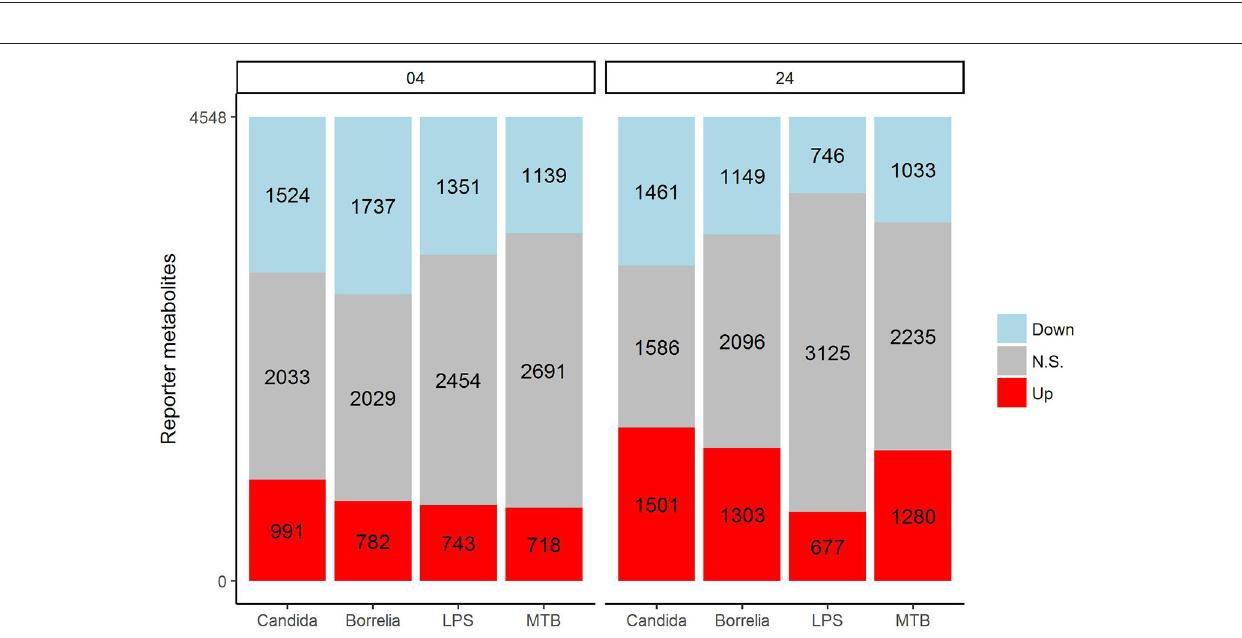
FIGURE 6 | KEGG metabolic pathways that discriminated between Borrelia , LPS, and MTB-stimulated human PBMCs. Blue refers to significantly down regulation. Red refers to significantly up regulation. Gray means not significantly changed. A pathway is significantly changed if its FDR < 0.05.